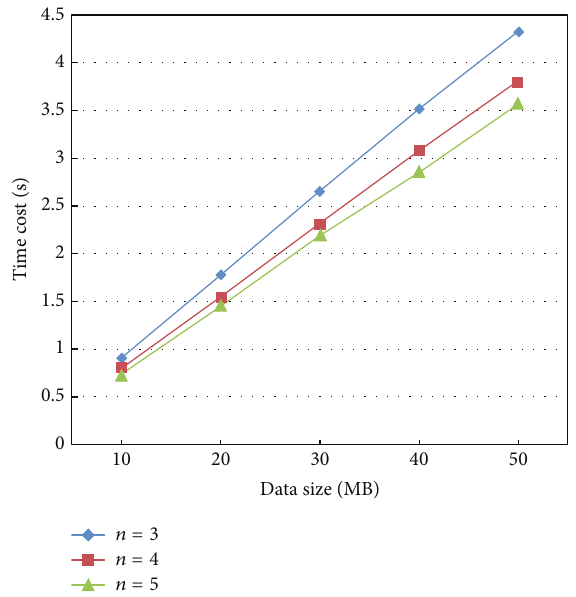
Figure 9: Time cost of EPPA under different size of scramble cube while rotation round is 𝑟 = 5